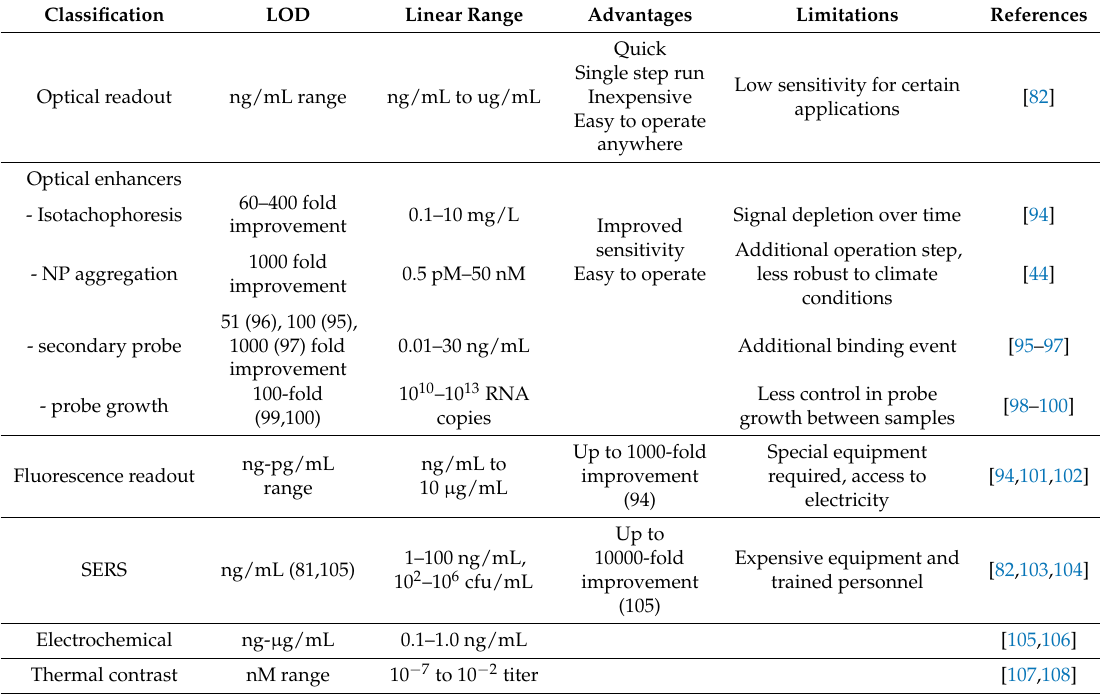
Table 2. Novel readout strategies applied in paper based